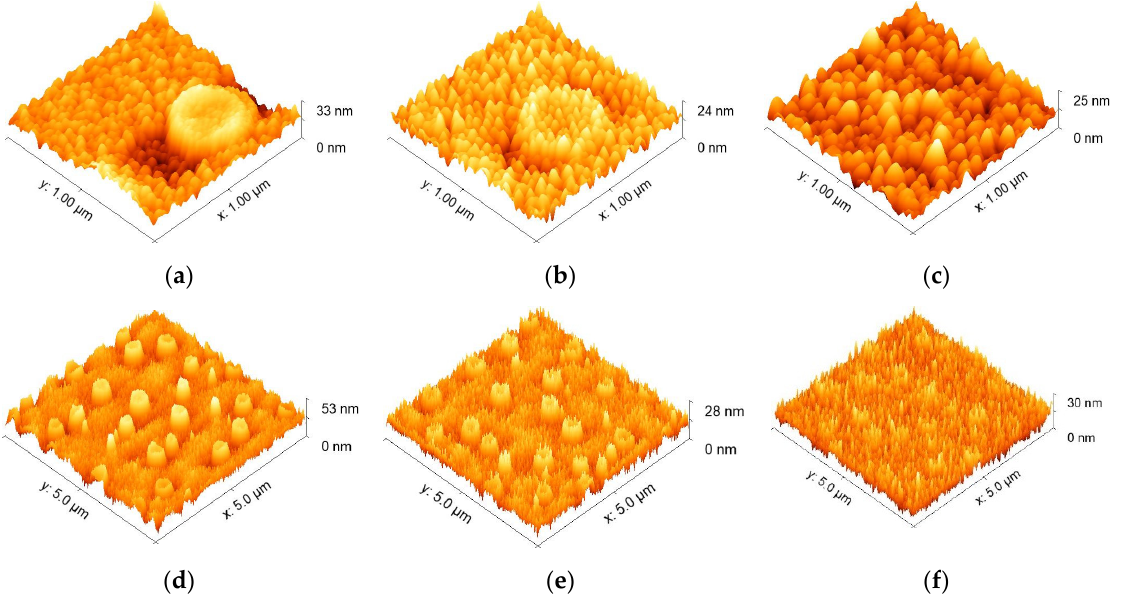
Figure 4. AFM images of the polymer foils deposited with Ag films, for a period of 30 min and at different frequencies: 1 Hz ( a , d ), 3 Hz ( b , e ), and 10 Hz ( c , f ). The images are grouped by deposition conditions corresponding to the same sample and were obtained at different scanning areas.